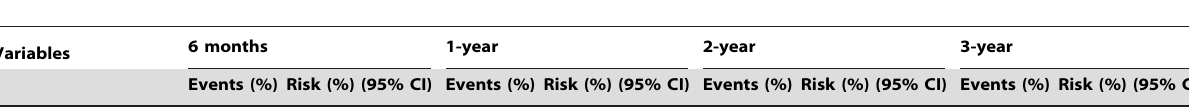
Table 2. Cumulative risk of vascular events in patients with dizziness/vertigo and those without.